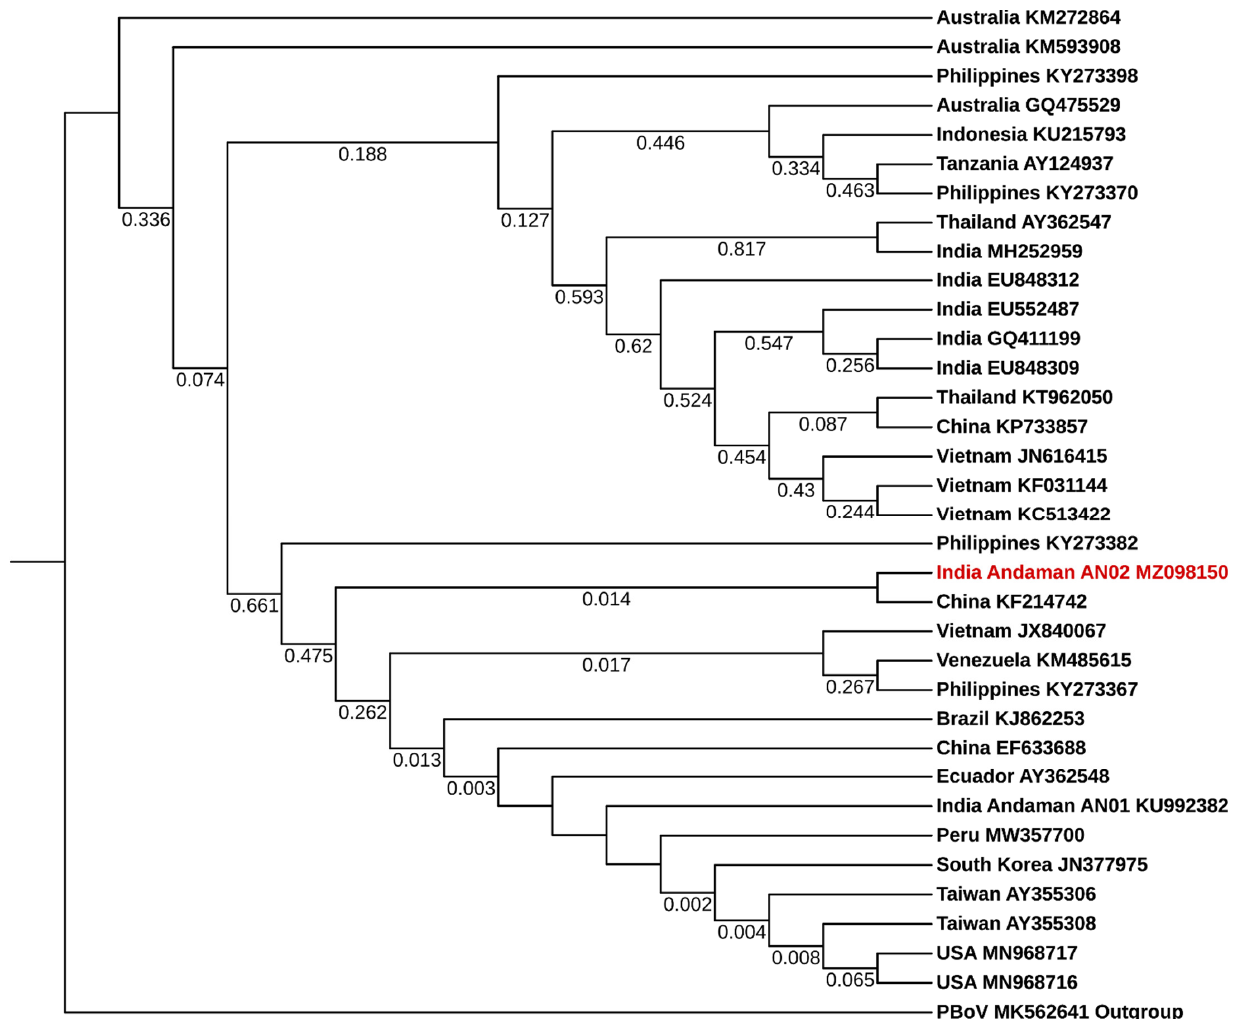
Figure 2. Phylogenetic tree of nonstructural protein 1 (NS1) gene of IHHNV. The Genbank accession numbers are provided along with the country name and the IHHNV sequence obtained in this present study (Genbank accession number MZ098150) was highlighted in red colour text. The tree was constructed using the maximum likelihood method with Kimura 2-parameter model (K2). The NS1 gene of porcine bocavirus (PBoV) was used as an outgroup (Genbank accession number MK562641).